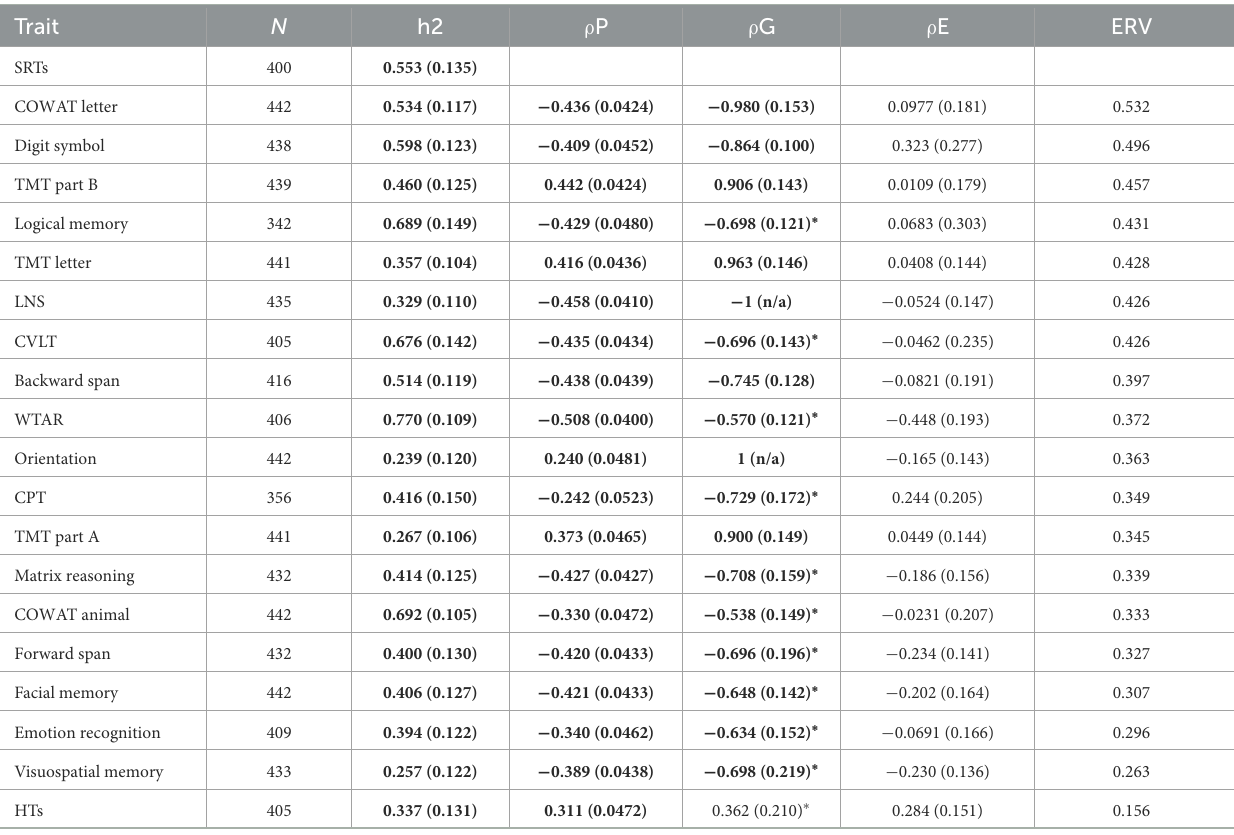
TABLE 1 Results from the univariate and bivariate quantitative genetic analyses.